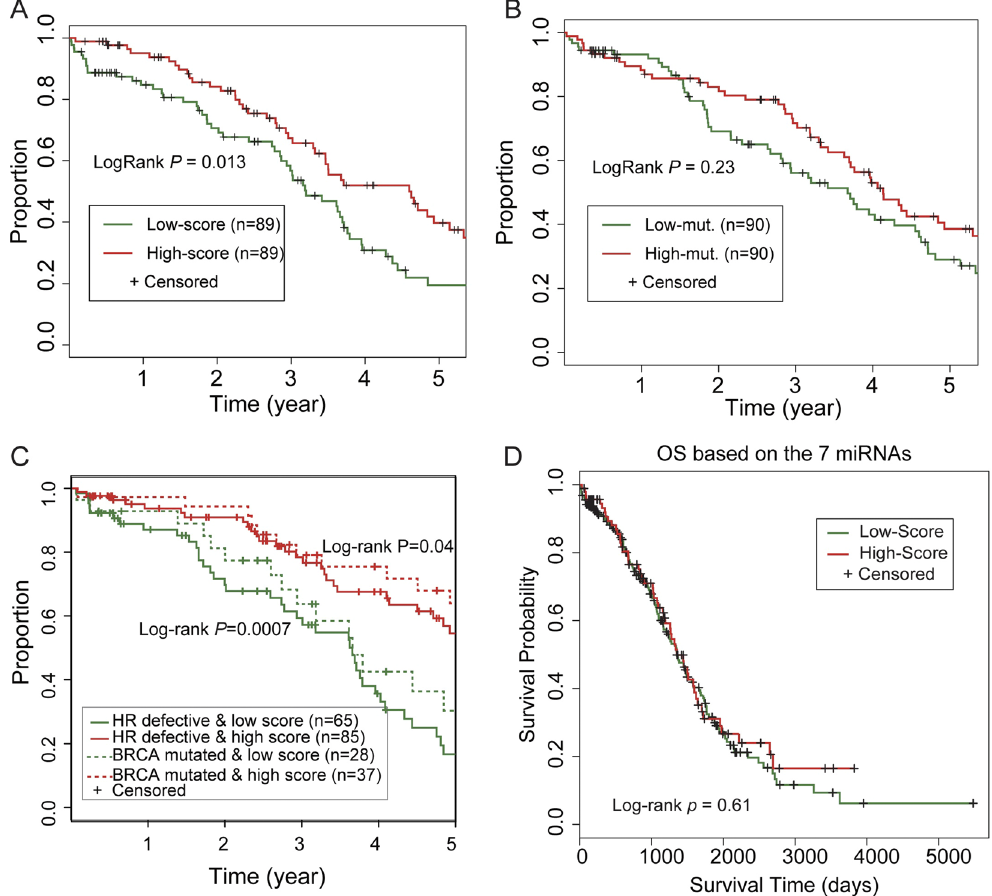
Figure 5. The 10-miRNA-score is a better predictor for the outcome of ovarian cancer patients treated with platinum agents than indexes of DNA damage. ( A ) The patients with different 10-miRNA-scores but similar number of mutations still show significantly different outcomes. ( B ) The number of mutations is not significantly associated with survival differences after controlling for the 10-miRNA-score. ( C ) A high 10-miRNA-score was significantly associated with improved survival in HR-defective patients or in BRCA1/2- mutated patients. ( D ) The alternate 7-miRNA-score could not significantly differentiate the survival time of ovarian cancer